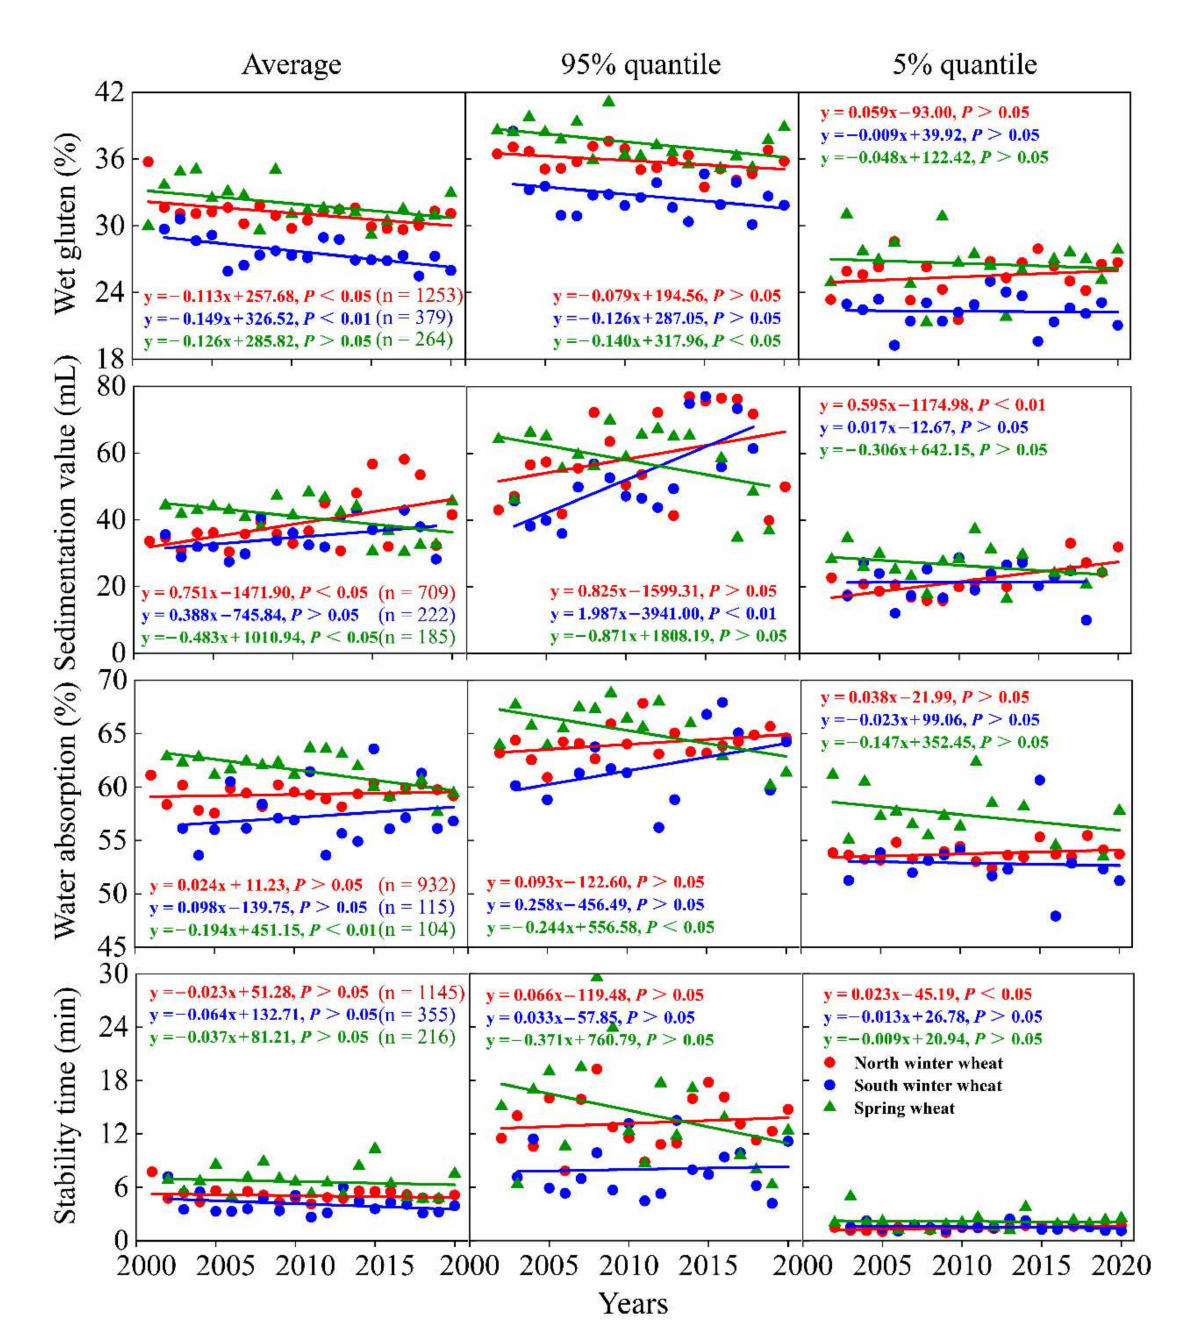
Figure 4. The average value, 95% quantile value and 5% quantile value of wet gluten, sedimentation value, water absorption, and stability time of wheat varieties released in 2001–2020 for three wheat- growing regions. Table 2. The proportion of wheat varieties in different protein quality groups for three wheat-growing regions from 2001 to